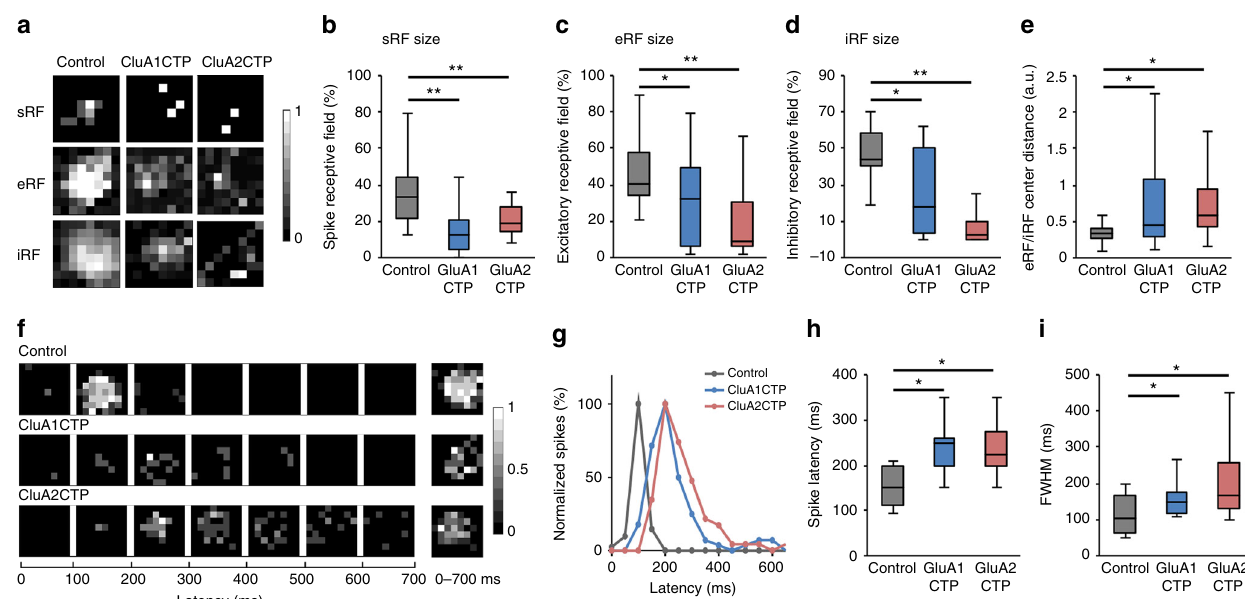
Fig. 7 GluACTP expression disrupts spatial and temporal receptive visual fi eld properties. a Representative maps of spiking RFs (sRFs), excitatory RFs (eRFs), and inhibitory RFs (iRFs) in control, GluA1CTP- and GluA2CTP-expressing neurons. b-d Both GluA1CTP and GluA2CTP expression signi fi cantly decreased the size of sRF ( b , n = 28, 14, 8), eRF ( c , n = 18, 19, 20), and iRF ( d , n = 18, 12, 13). e The distances between eRF and iRF centers were signi fi cantly larger in GluA1CTP- and GluA2CTP-expressing neurons. f Representative tRF maps in control, GluA1CTP- and GluA2CTP-expressing neurons. g Plot of spike numbers over the 700 ms recording period normalized to peak spike numbers per 100 ms bin. The control tRF is limited to the fi rst 200 ms while tRFs in GluA1CTP- and GluA2CTP-expressing neurons were signi fi cantly extended and delayed. h, i Both spike latency ( h ) and the full width at half maximum (FWHM, i ) of the tRF spiking response increased signi fi cantly in GluA1CTP- and GluA2CTP-expressing neurons compared to control neurons. Control: n = 12; GluA1CTP: n = 9; GluA2CTP: n = 8. * P < 0.05, ** P < 0.01. ANOVA with Newman – Keuls